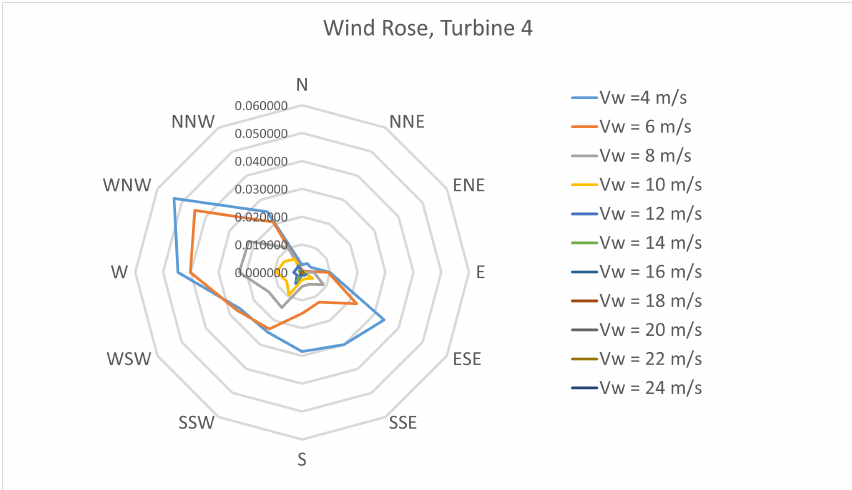
Figure A3. Wind Rose 4—wind speed and wind direction probability for wind turbine 4.